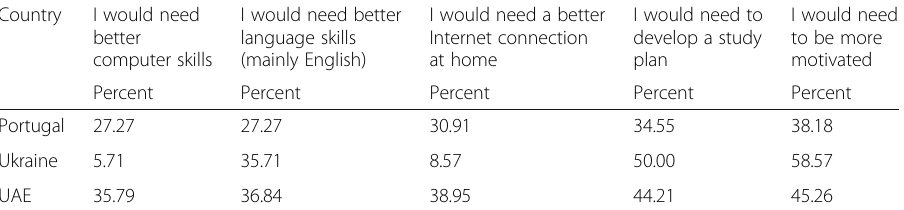
Table 8 Preparation students feel they need before enrolling in distance education courses (More than one could be chosen)